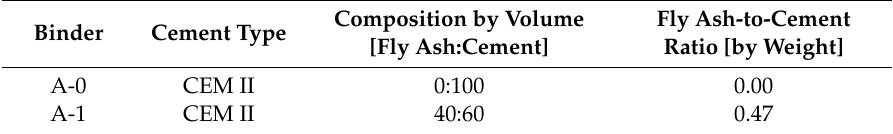
Table 1. Binder compositions tested following the Okamura procedure.